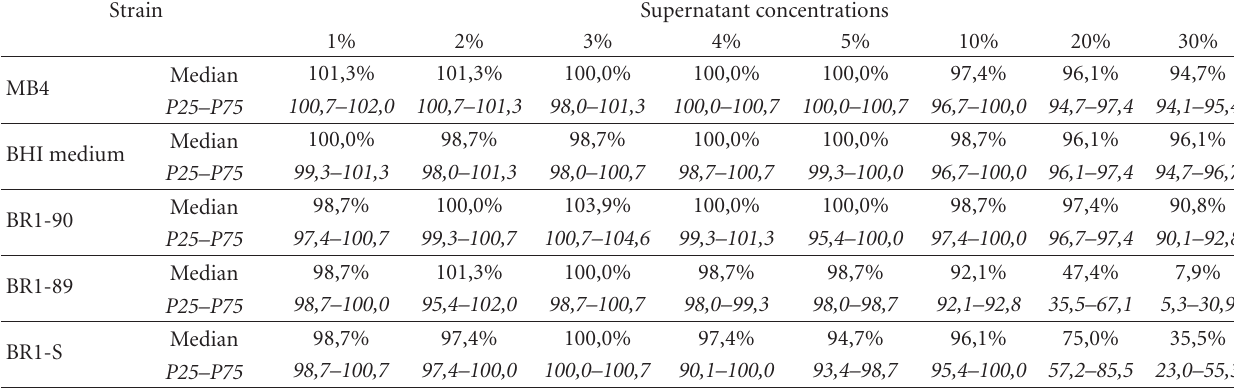
The BHI medium and the supernatant of the MB4 wild-type strain were used as a control sample not containing LLO. The percent given is of living cells in the PI assay for di ff erent final IPTG-treated supernatant concentrations of 1–30%, when Jurkat cells were incubated for 30min at 22 ◦ C (median values, P25 – P75 , n = 4). The incubation medium contained 4% inactivated NCS. The activities of BR1-89, BR1-90, and BR1-S were not significantly di ff erent from each other. Their activities were all significantly higher compared with that of the control supernatant. Table 6: Survival of Jurkat cells treated with di ff erent concentrations of B. subtilis